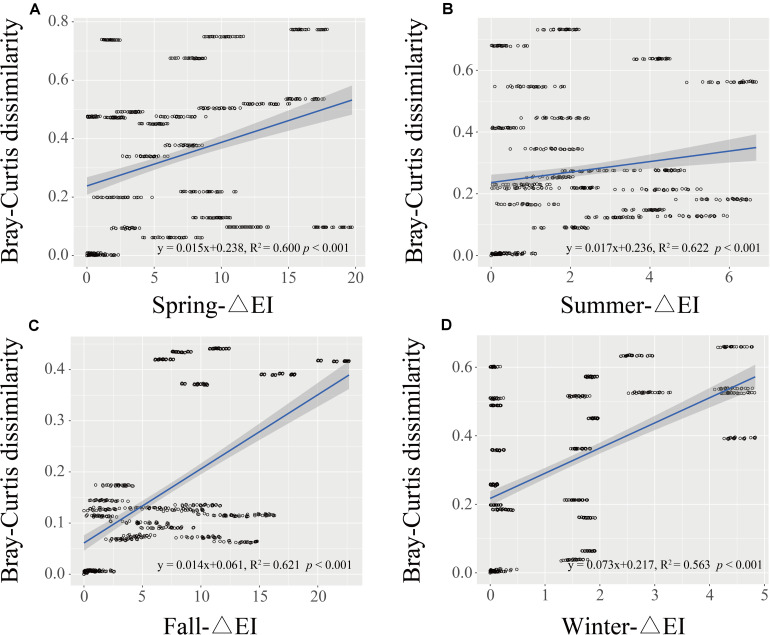
The regression between Bray-Curtis dissimilarity and variation of Delta EI in four seasons (A–D represents spring to winter). The black line represents the linear regression, and P-values were calculated to indicate significant differences.